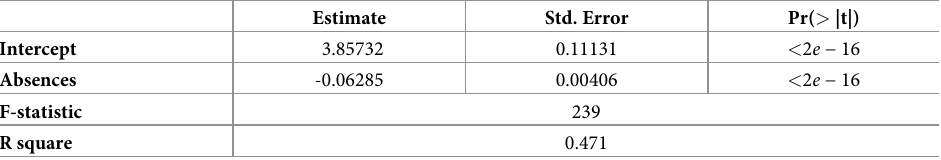
Table 3. The results of the Linear Regression for the GPA variable using the whole